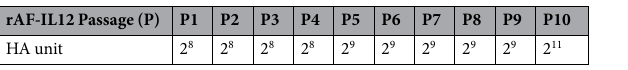
Table 1. Viral titers of passaged rAF-IL12.